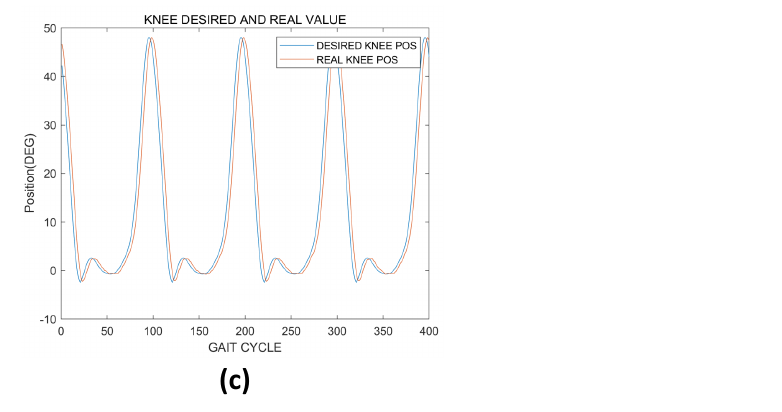
Figure 15. Experiment results. ( a ) Desired pelvic obliquity motion motor position command (indi- cated by blue line) and real value (indicated by red line). ( b ) Desired hip flexion/extension motion position command (indicated by blue line) and real value (indicated by red line). ( c ) Desired knee flexion/extension motion position command (indicated by blue line) and real value (indicated by red line). These three graphs show that the system can follow the human gait motion with little